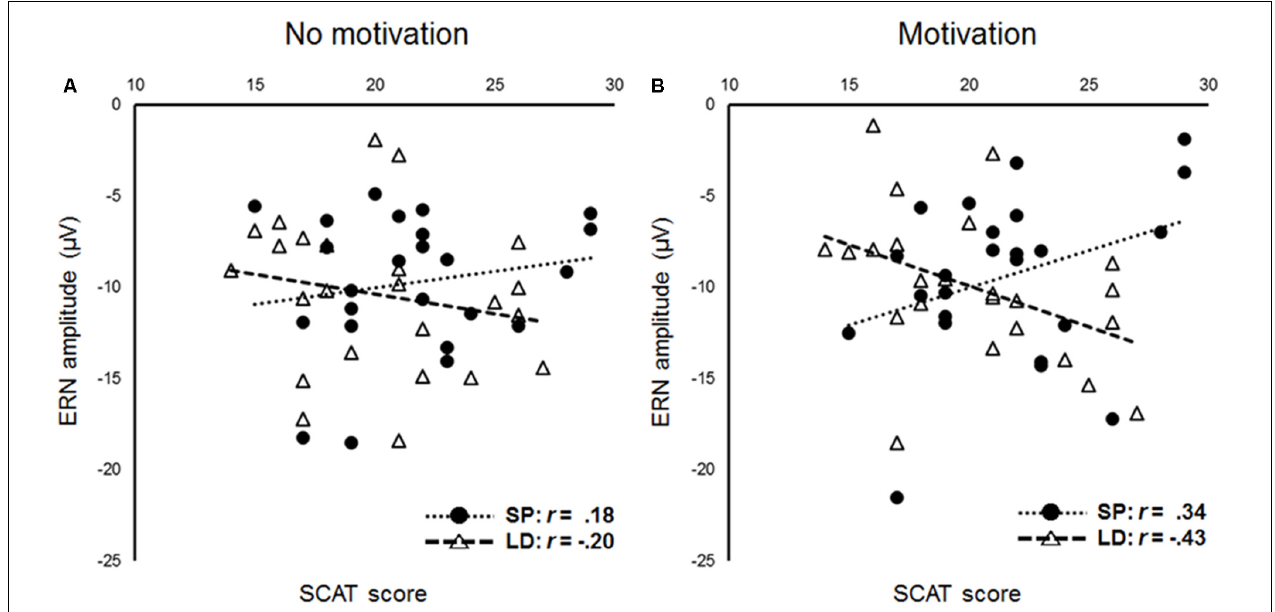
FIGURE 3 | Scatter plots showing the relationships and correlations between scores on the SCAT and amplitudes of error-related negativity (ERN) [ A , no motivation condition, B , motivation condition, circle: sprinters (SP), triangle: long-distance runners (LD)].